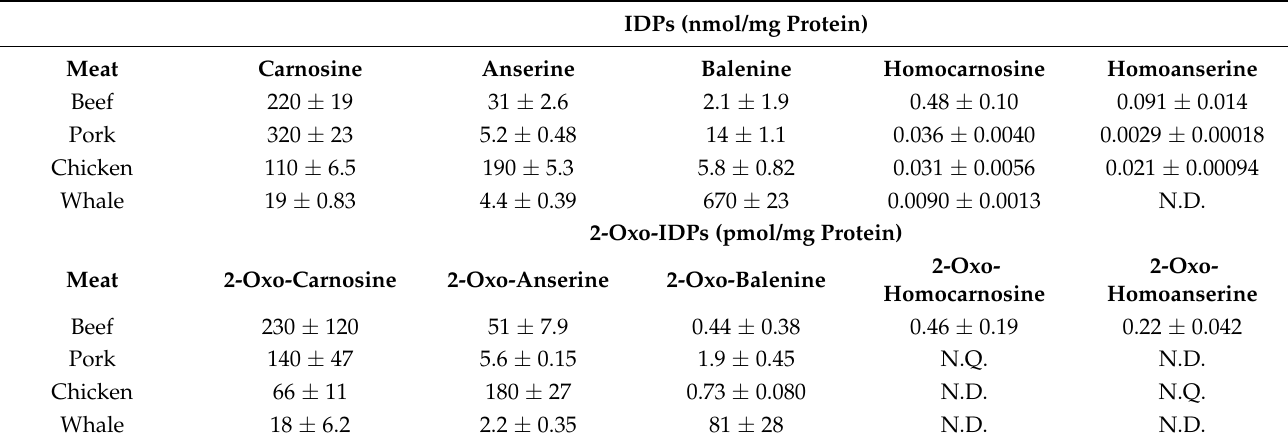
Table 4. Quantitative HPLC-ESI-MS/MS analysis of IDPs and 2-oxo-IDPs in meat samples. IDPs (nmol/mg Protein)